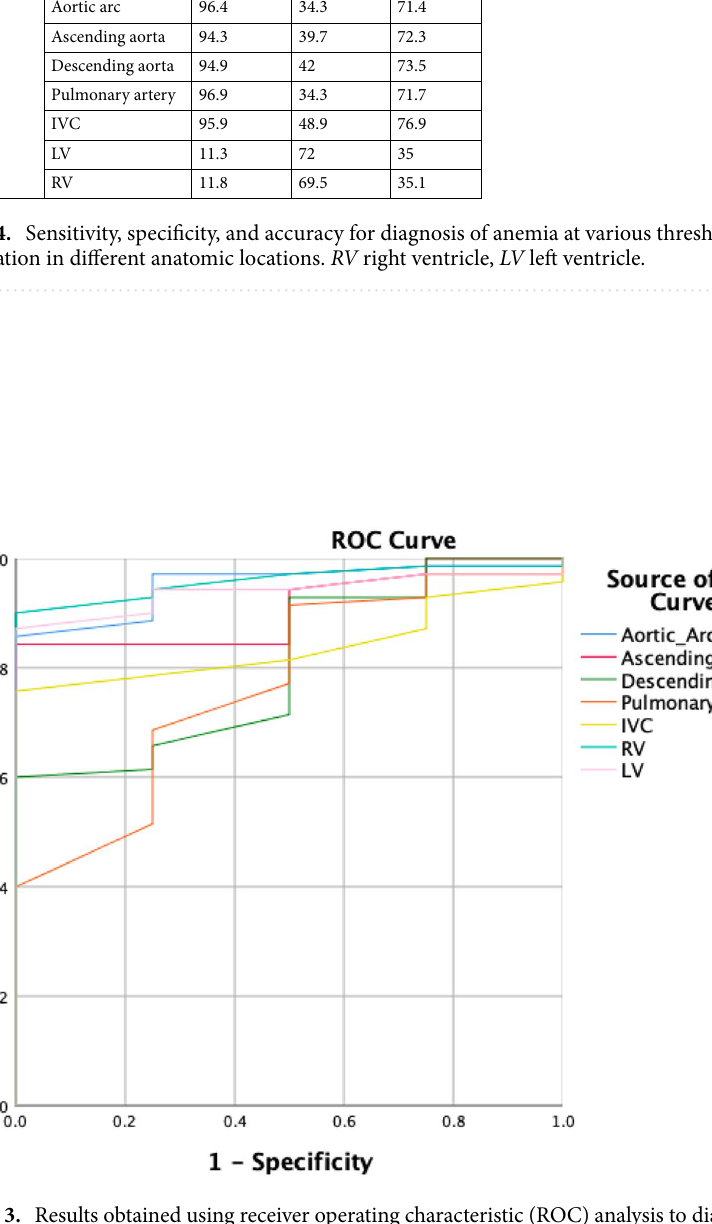
Figure 3. Results obtained using receiver operating characteristic (ROC) analysis to diagnose severe anemia. IVC inferior vena cava, RV right ventricle, LV left